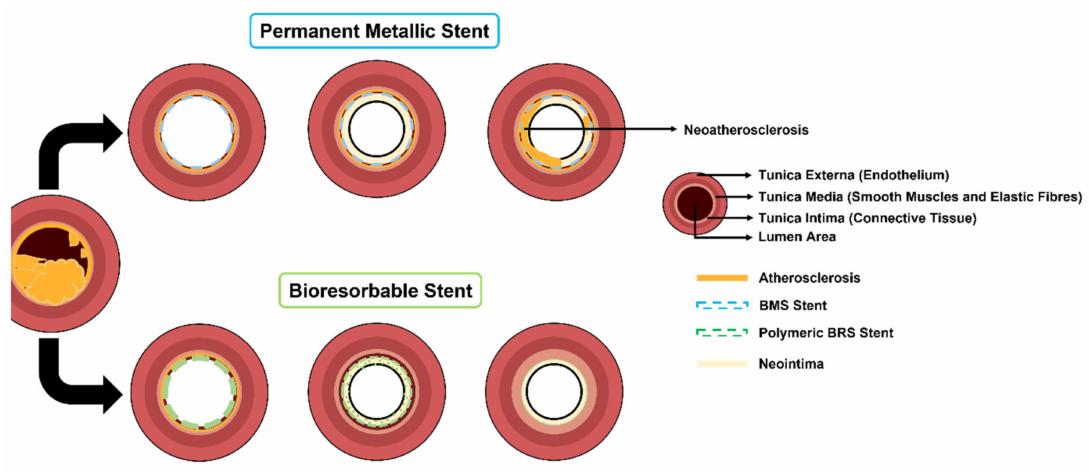
Figure 4. Comparison between bioresorbable stents and permanent metallic-based